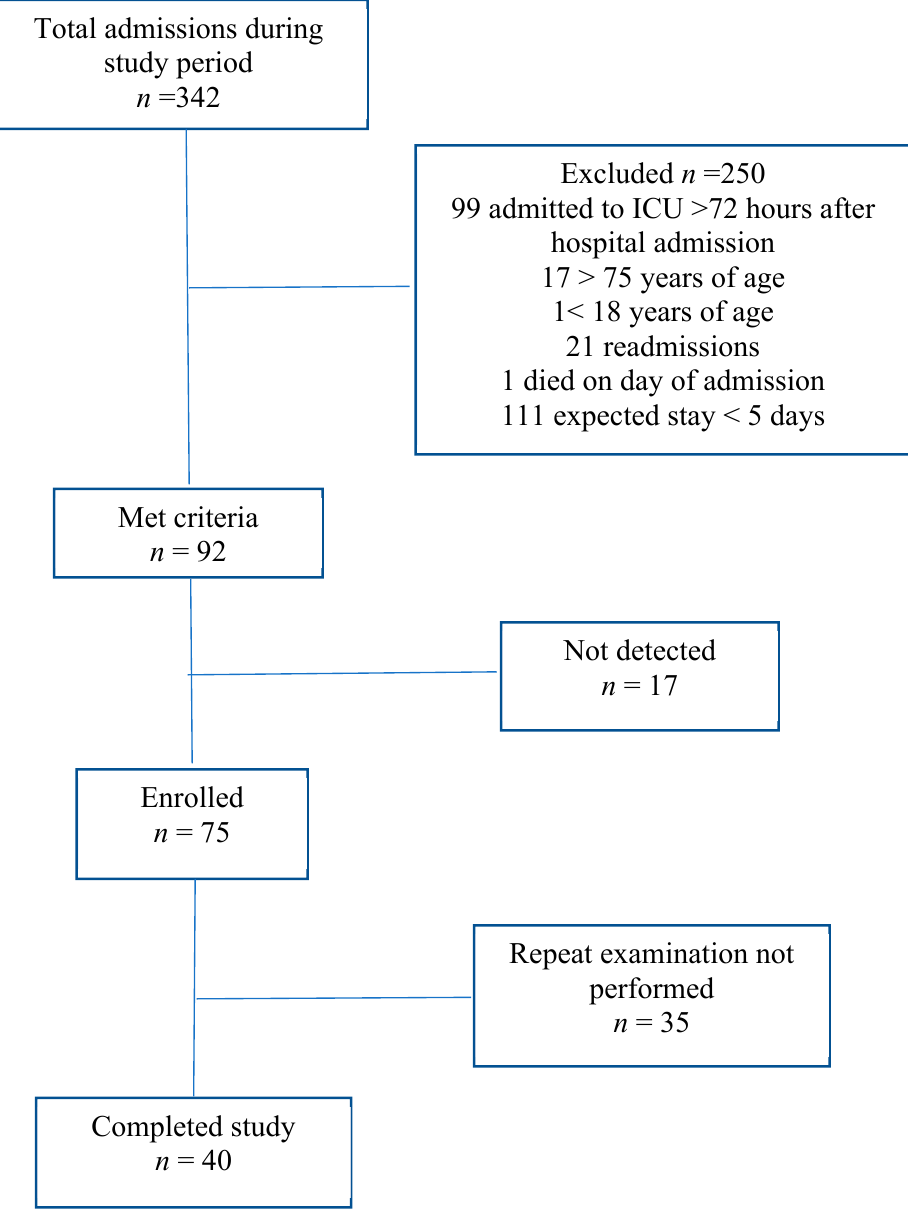
Figure 1. Flowchart of patient selection; see details in text. n-number of patients , ICU-intensive care unit.